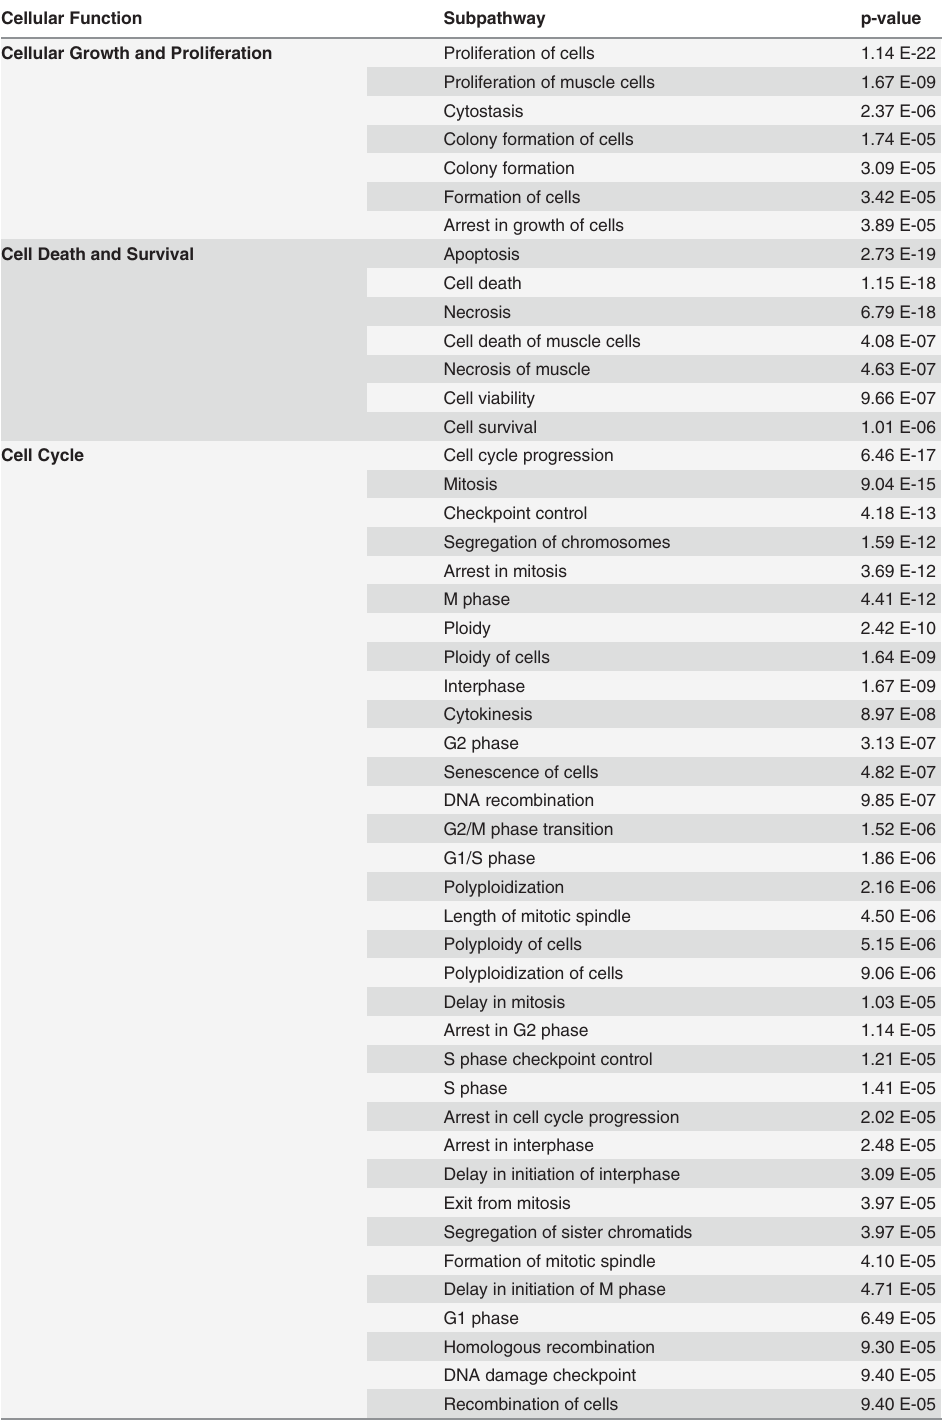
Table 2. Cellular functions significantly altered by Cfl2